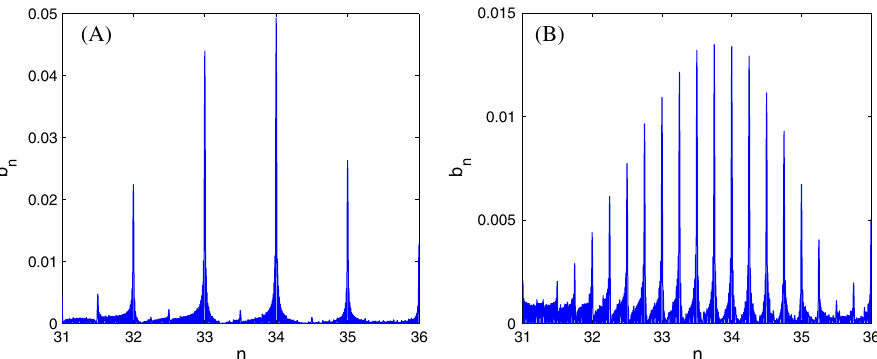
FIG. 4. Average bunching factor as a function of the harmonic number at the entrance of the radiator: (a) conventional EEHG and triple-modulator scheme with seed3 off; (b) triple-modulator scheme with seed3